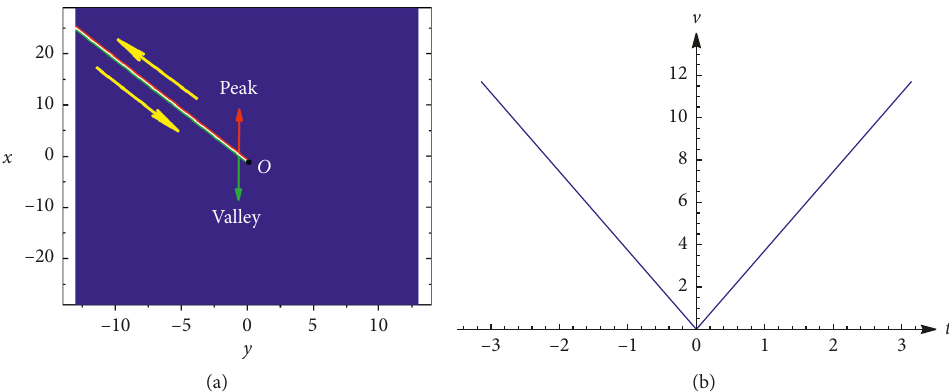
Figure 4: (a) The half-line-typed trajectory of the nonautonomous lump wave via the solution (9). (b) The velocity curve of the non- autonomous lump wave with time. The variable coefficients are taken as α Figure